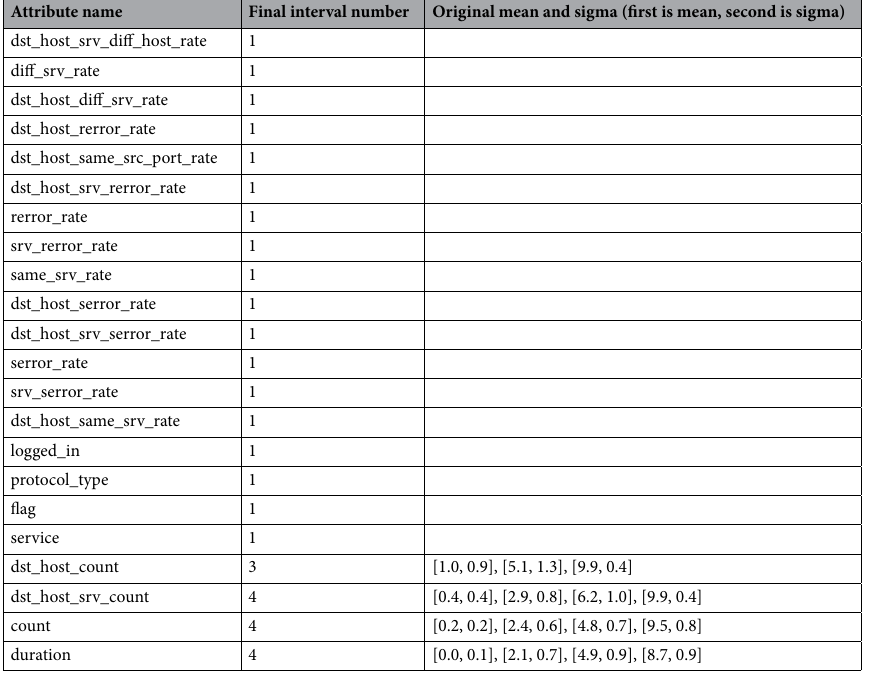
Table 5. Final interval number of selected attributes. Only list the original mean and sigma of attributes with interval number greater than 1.